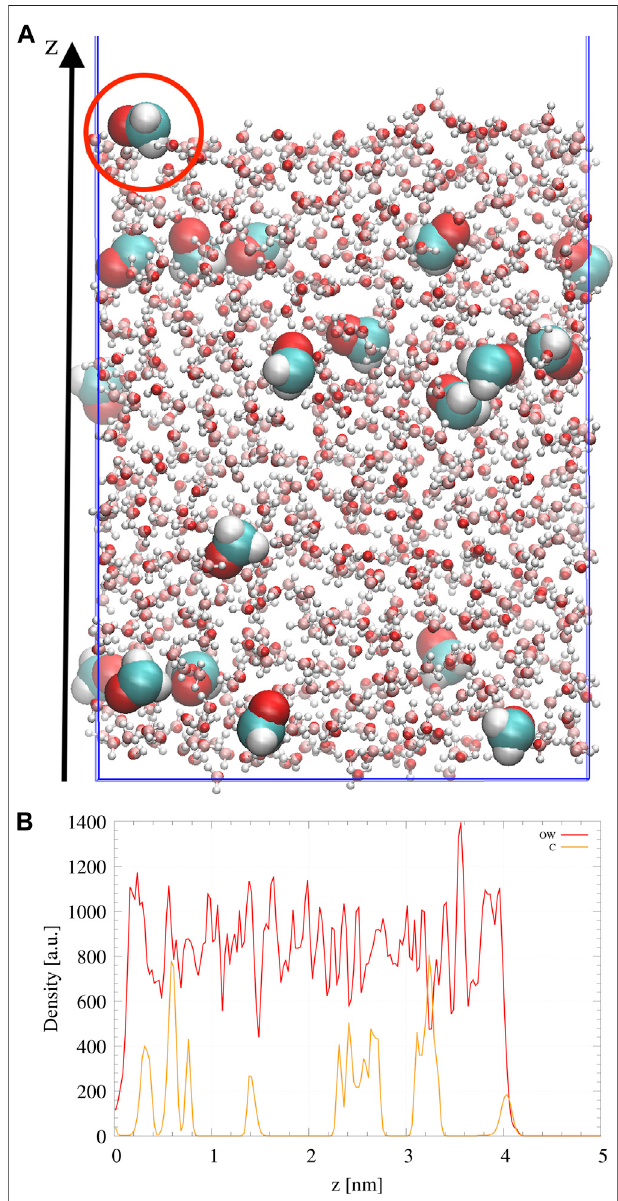
FIGURE 1 | (A) Side view of the doped ice slab. Water is represented in light colors and CH 2 O by van der Waals spheres. The picked surface CH 2 O moleculeishighlightedbyaredcircle. (B) Atomicdistributionsinarbitraryunits alongthez direction ofthe Oxygen atoms ofH 2 O(OW)or Carbon atoms ofCH 2 O(C).Forabettervisualization,Carbondensityhasbeenmultipliedbya factor 10.